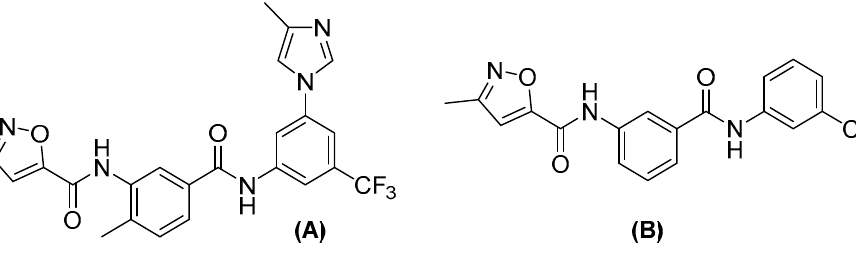
Figure 10. AWL-II-38.3 ( A ) and T56-LIMKi ( B